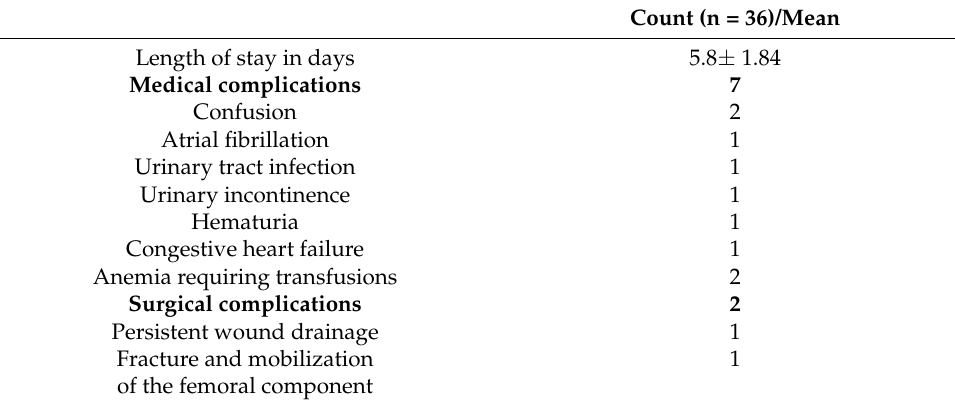
Table 3. Postoperative